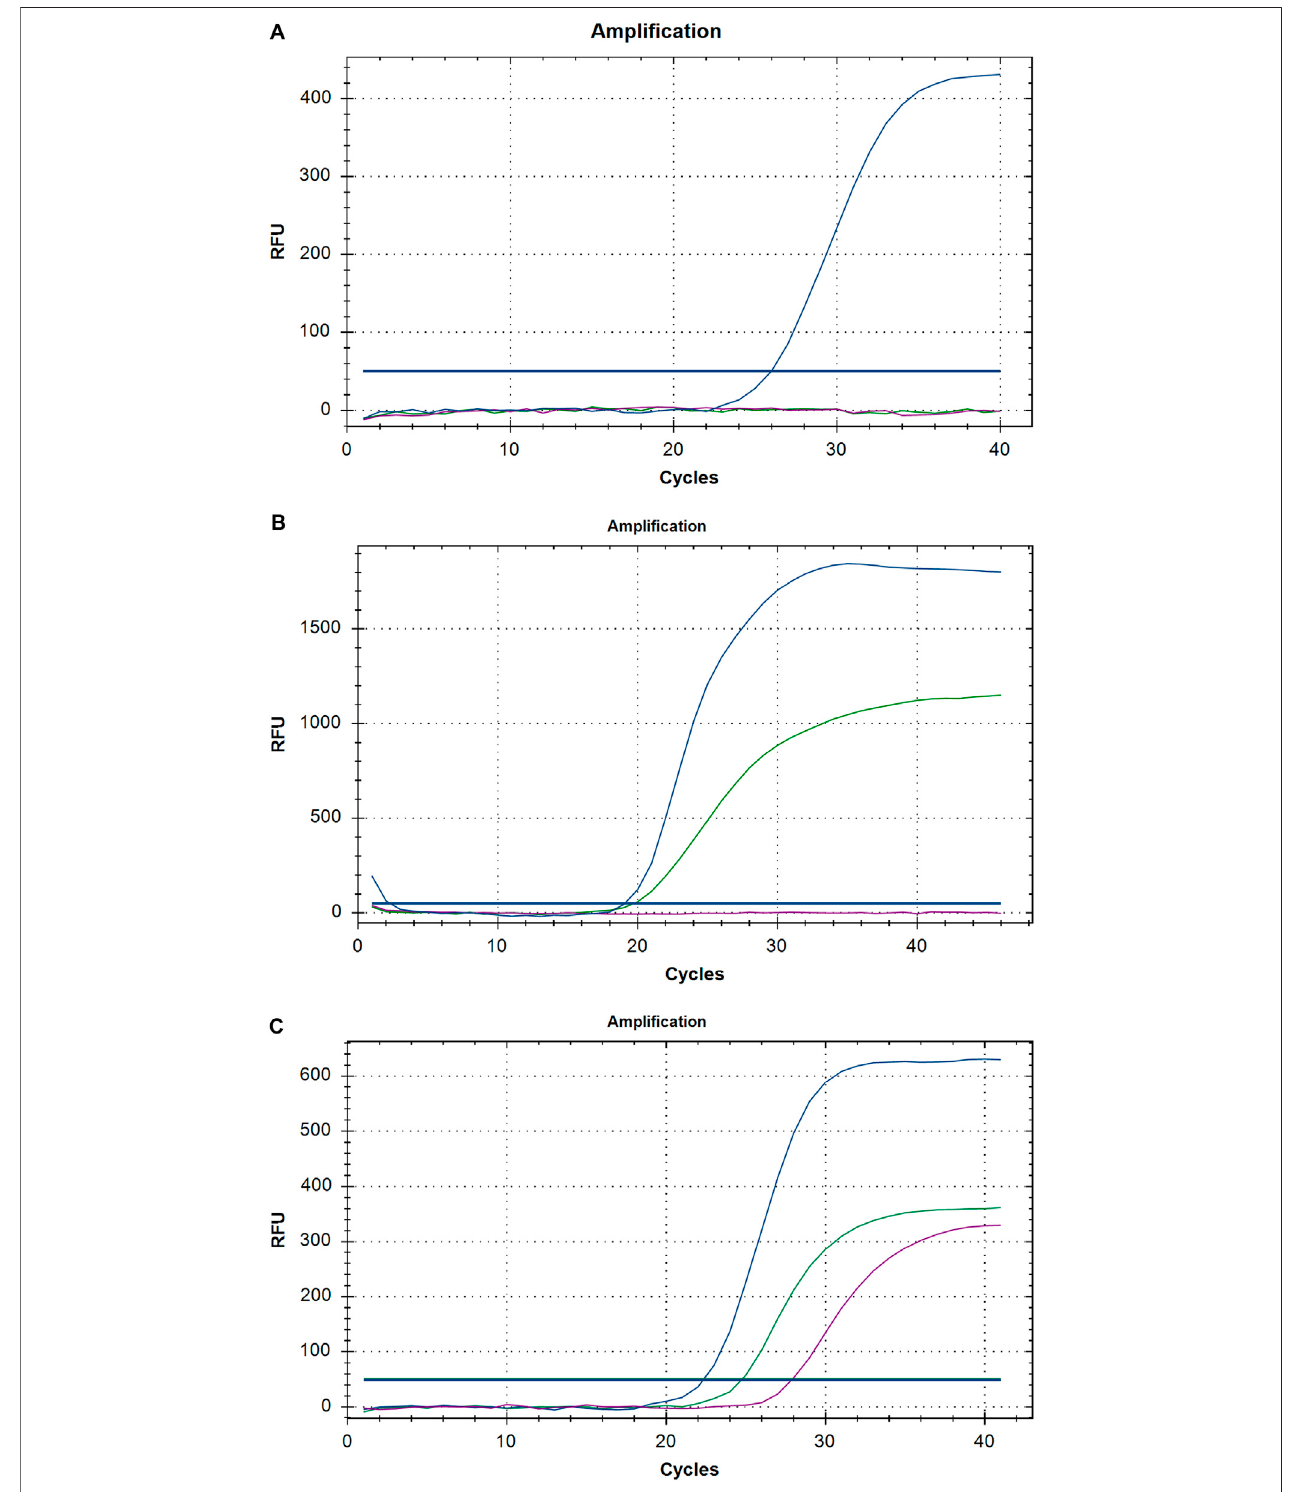
FIGURE 1 | A representative graph of Real-time PCR exhibiting (A) United Kingdom, (B) South African and Brazilian (C) other then VOC of SARS-CoV-2.